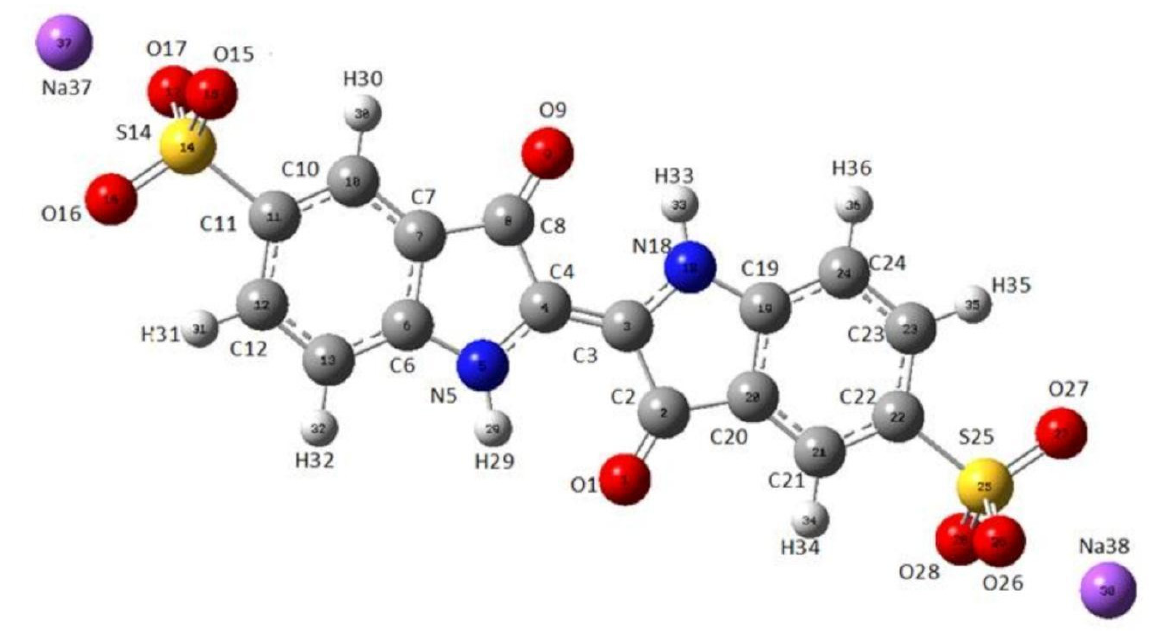
Figure 3. The optimized geometry of indigo carmine using B97D/cc-pVTZ level of theory. The molecular lengths and bonds of indigo carmine are listed in Table S2 of the Sup- plementary Material. However, it is challenging to present a true geometry optimization